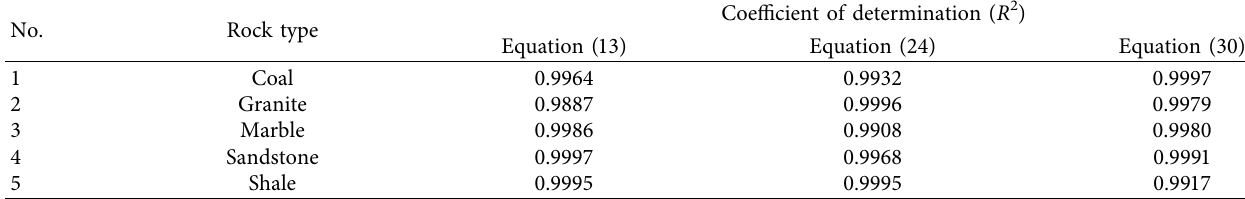
Table 1: Error analysis of the Damage constitutive